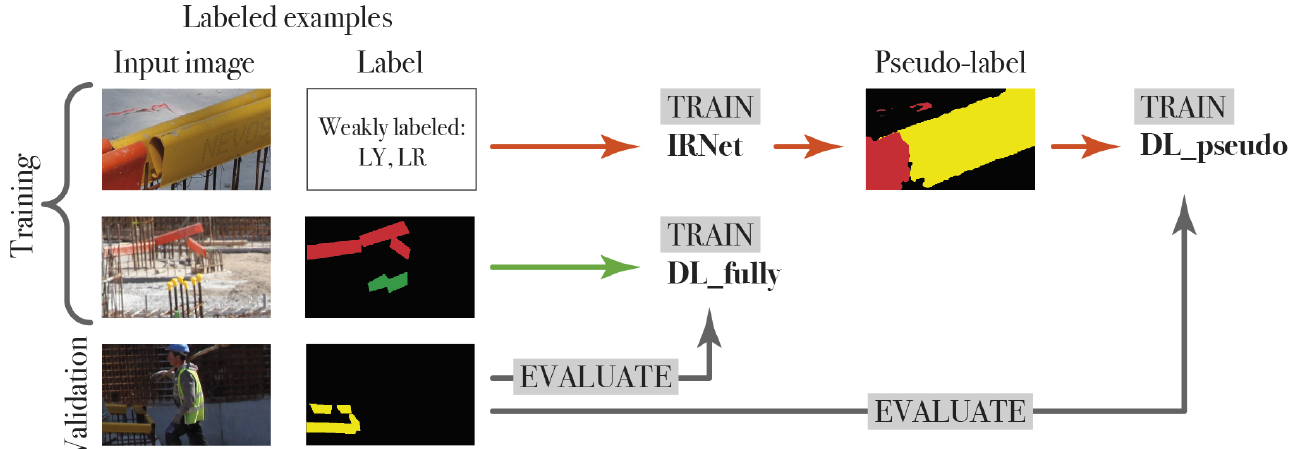
Figure 2. IRNet and DL_fully (fully-supervised Deeplabv3+) are trained using the training set. DL_pseudo is trained with the pseudo-labels generated by IRNet. The testing images are used to evaluate IRNet, DL_pseudo and